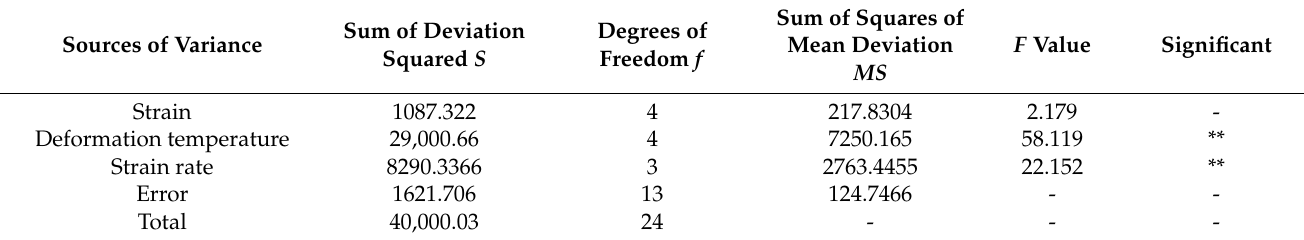
Table 3. Variance analysis of flow stress of Al-Zn-Mg-Cu